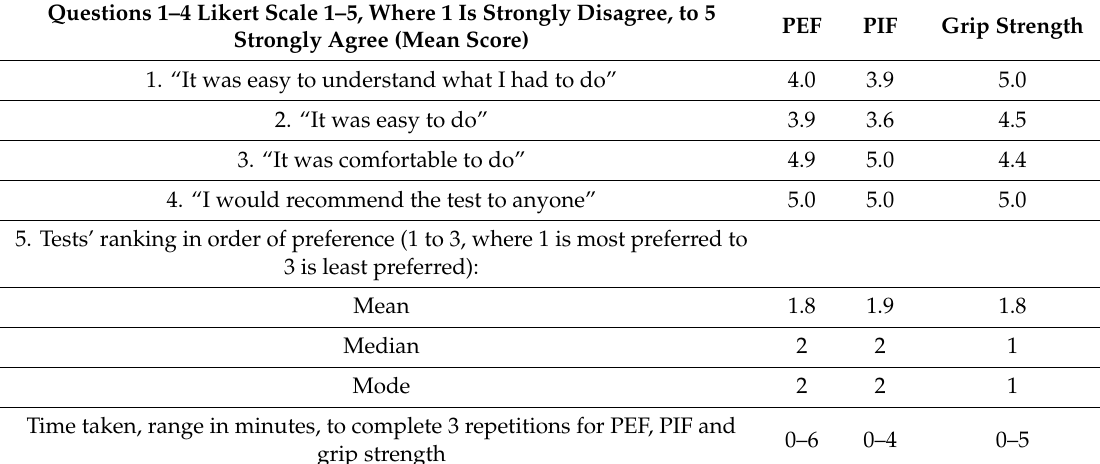
Table 4. Acceptability of measures of muscle strength to